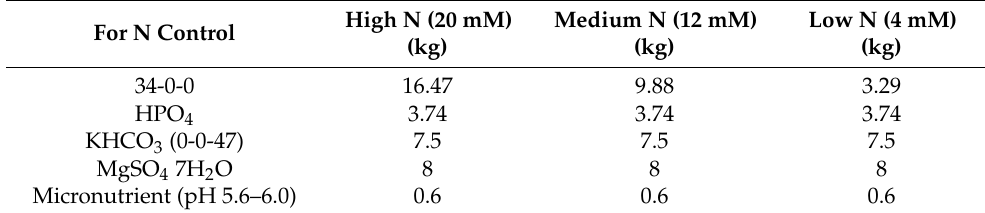
Figure 4. The experimental setup conducted in the greenhouse. Table 1. The nitrogen recipe used for corn